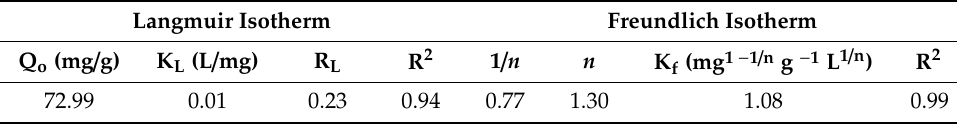
Table 2. Isotherm parameters for Cr(VI) adsorption on the dried SH-1 Live biomass. Langmuir Isotherm